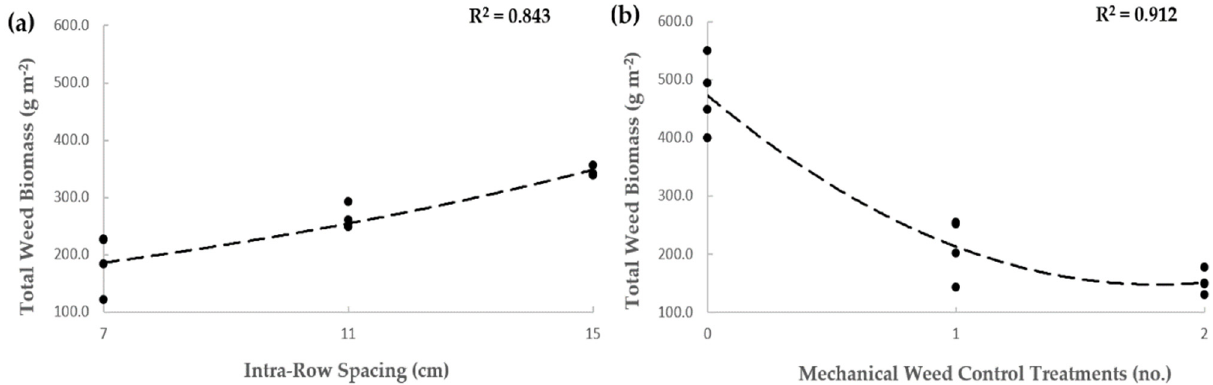
Figure 1. ( a ) The relationship between total weed biomass (g m − 2 ) and intra-row spacing (cm). ( b ) The relationship between total weed biomass (g m − 2 ) and the number of mechanical weed control treatments.